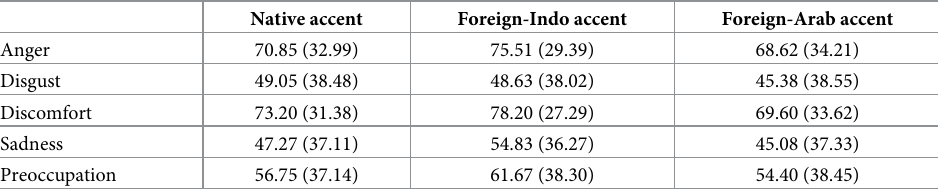
Table 7. Mean scores (SD) for each emotion across accents (native, foreign-Indo, and foreign-Arab).